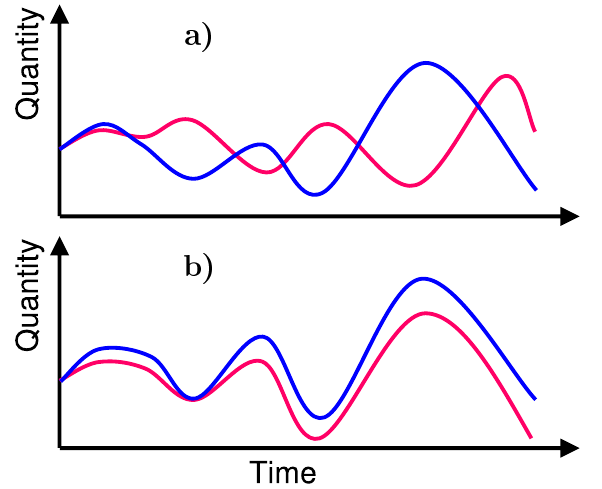
Fig. 1. Mixing ratio x of an arbitrary chemical tracer from two hy- pothetical simulations. The simulation setups differ only by a small chemical perturbation affecting x , and share identical initialization. Note that the simulations have near-identical statistical expectation with respect to dynamical quantities such as divergence and vor- ticity. However, the feedback between chemistry and dynamics causes a completely different sequence of dynamical patterns and associated tracer transport, and hence a low signal-to-noise ratio for the chemistry-related difference 1x among the two simulations (a) . Without feedback between chemistry and dynamics, however, 1x relates directly to the chemical perturbation, and it displays a high signal-to-noise ratio (b) .